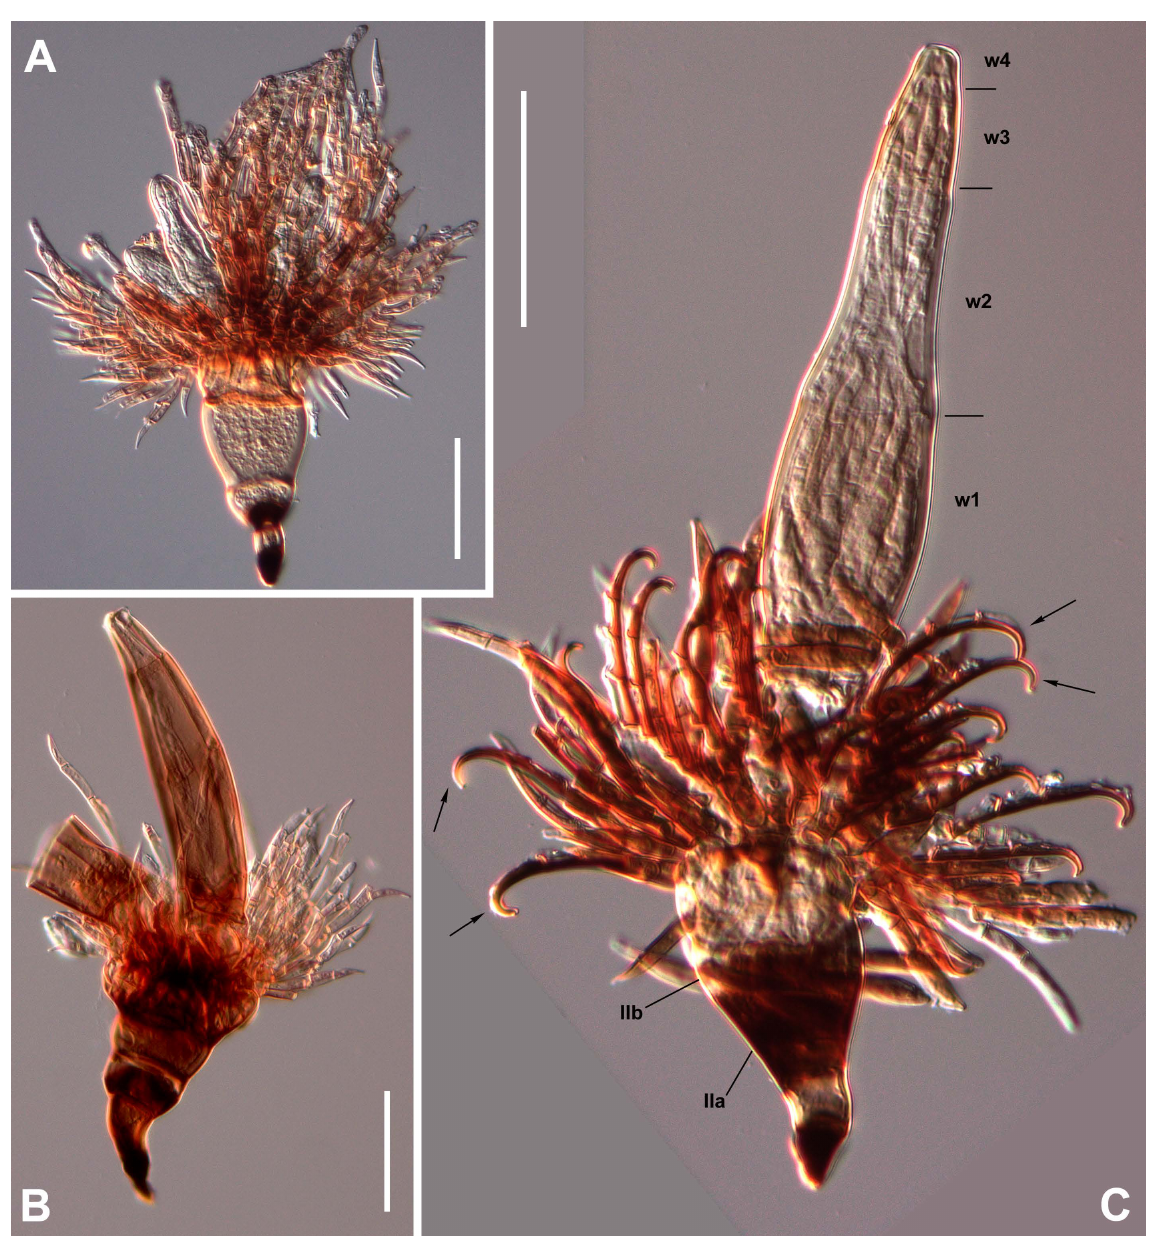
Fig. 15. Teratomyces spp. A – B . T. actobii Thaxt. Immature and mature thalli showing variability in receptacle pigmentation. – C . T. philonthi Thaxt. Mature thallus with labelled wall cell tiers (w and arcuate secondary appendages (arrows), and cells IIa–b of receptacle. Scale bars: 50 µm. Photographs from slides ZMUC C-F-122481 (A), ZMUC C-F-123544 (B), ZMUC C-F-122832